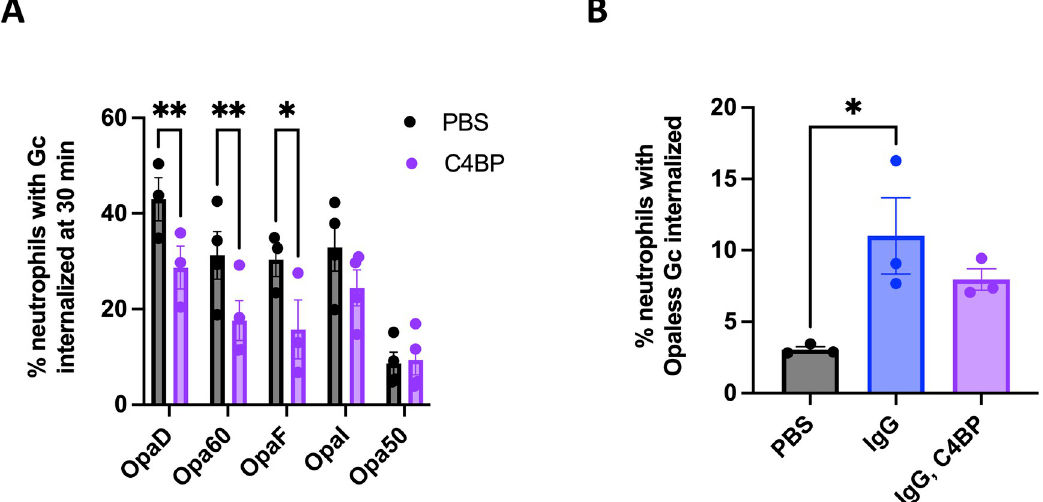
Fig 6. Binding of C4BP prevents internalization of CEACAM-binding Gc by neutrophils. (A) The indicated variants of Gc were incubated with C4BP (purple), or PBS (grey). The percentage of neutrophils with � 1 phagocytosed bacterium was calculated as in Fig 5C. Data represent the mean ± SEM of � 3 independent experiments. Statistical analyses were performed by two-way ANOVA followed by Sidak’s multiple comparisons. (B) Opaless Gc was incubated with C4BP (50 ug/mL), opsonized in rabbit anti-Gc IgG (80 μ g/mL, 20 minutes, 37˚C), sequentially incubated with IgG then C4BP, or left untreated. Unopsonized Gc and IgG-opsonized Opaless Gc bound similar amounts of C4BP ( S8E Fig ). The percentage of neutrophils with � 1 phagocytosed bacterium was calculated as in (A). Statistical analyses were performed by one-way ANOVA followed by Tukey’s multiple comparisons. Opaless Gc incubated with C4BP behaved similarly to Opaless Gc (not shown). � p < 0.05, �� p < 0.01.